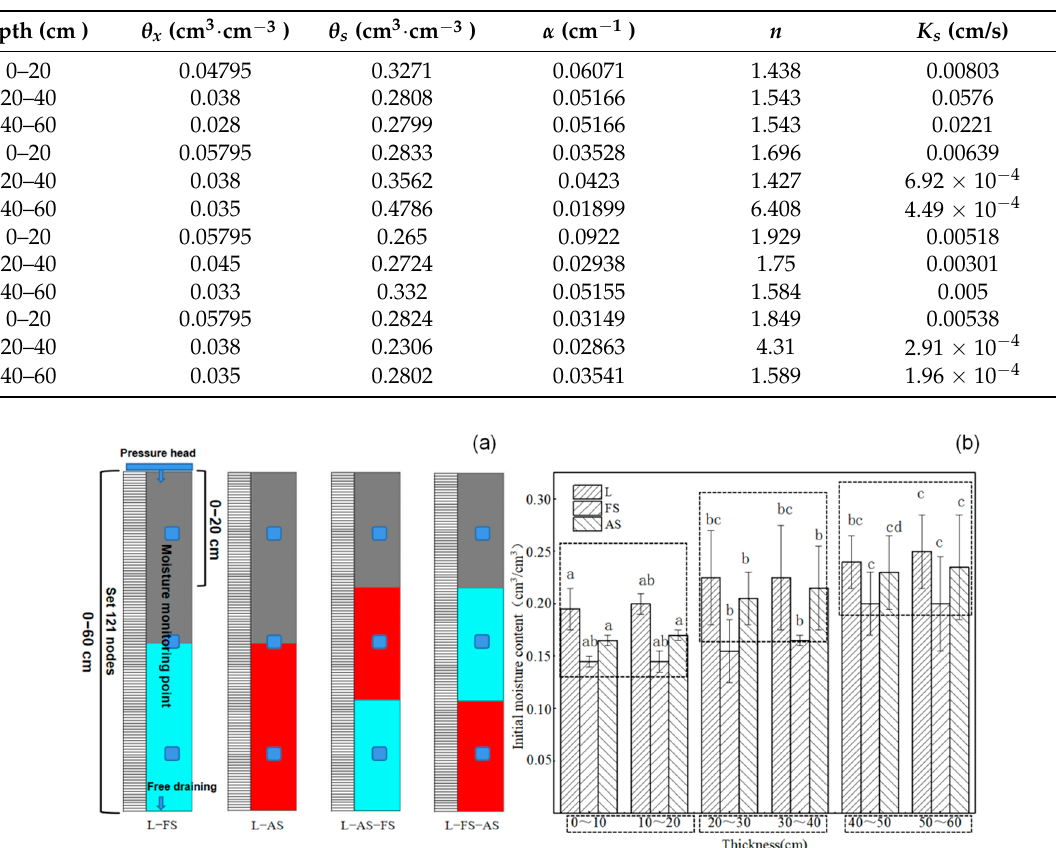
Table 5. Hydraulic parameters of soil bodies of different structures optimized by inversion.